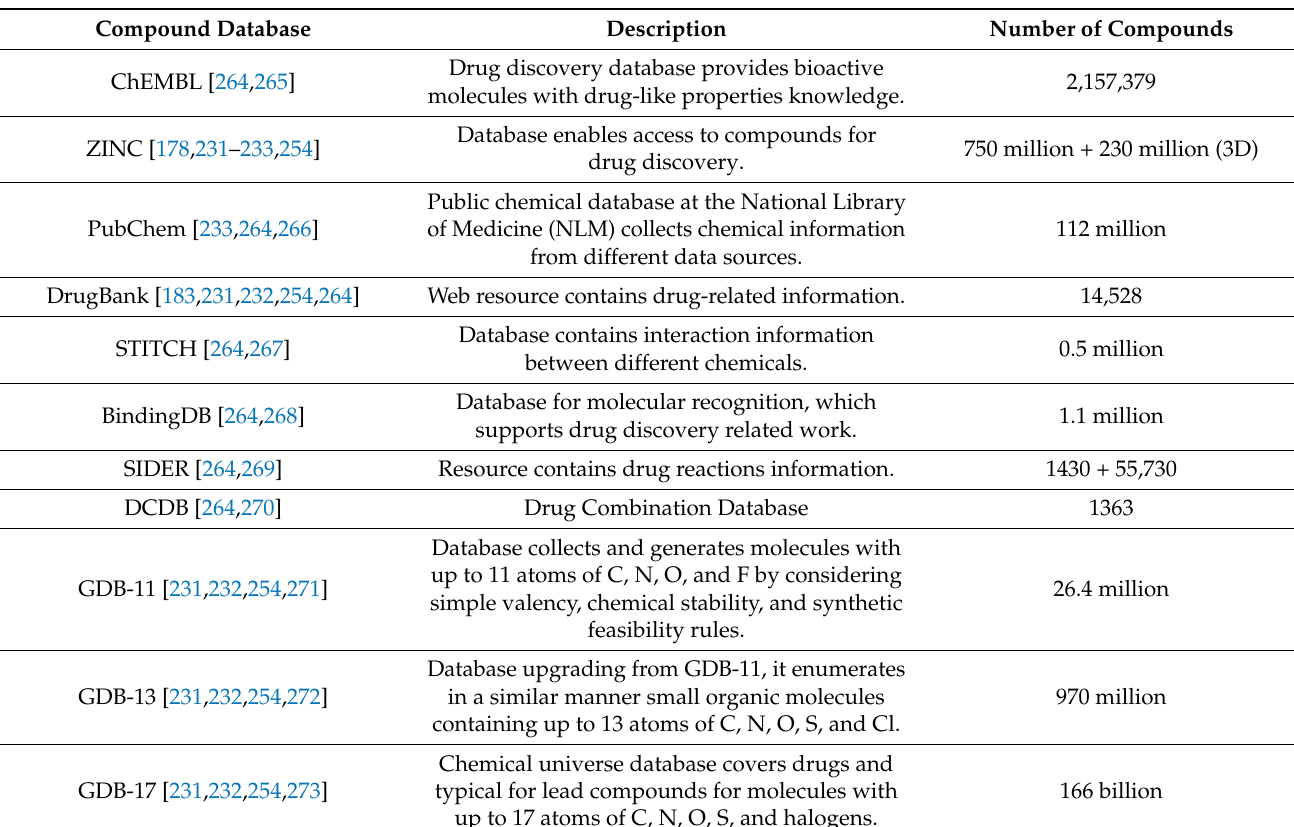
Table 1. Databases for AI based drug